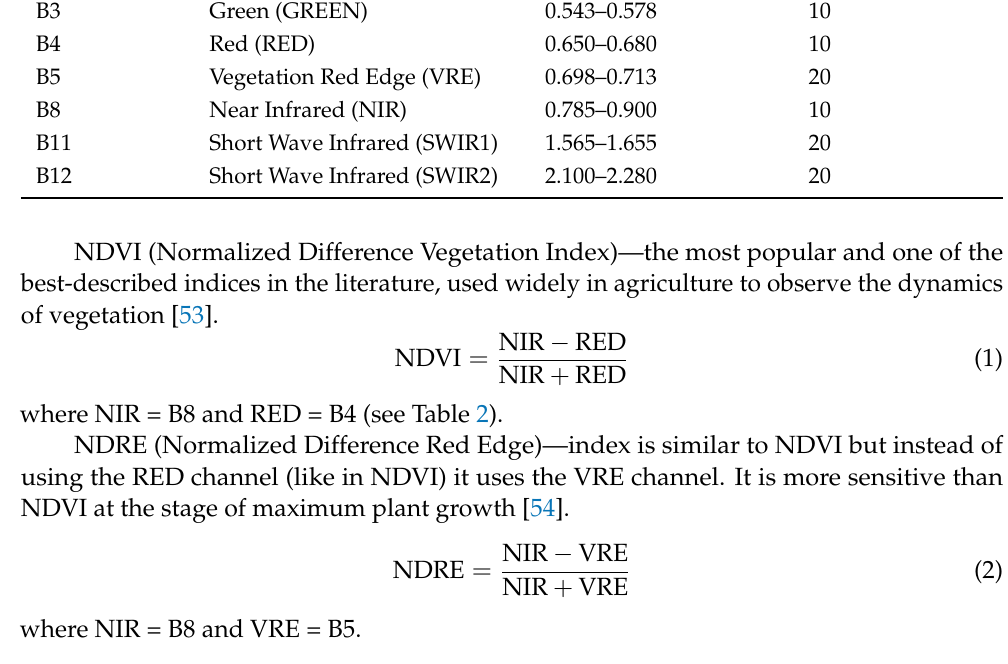
Table 2. Spectral bands for the Sentinel-2 sensors, which were used for VI calculation [47].